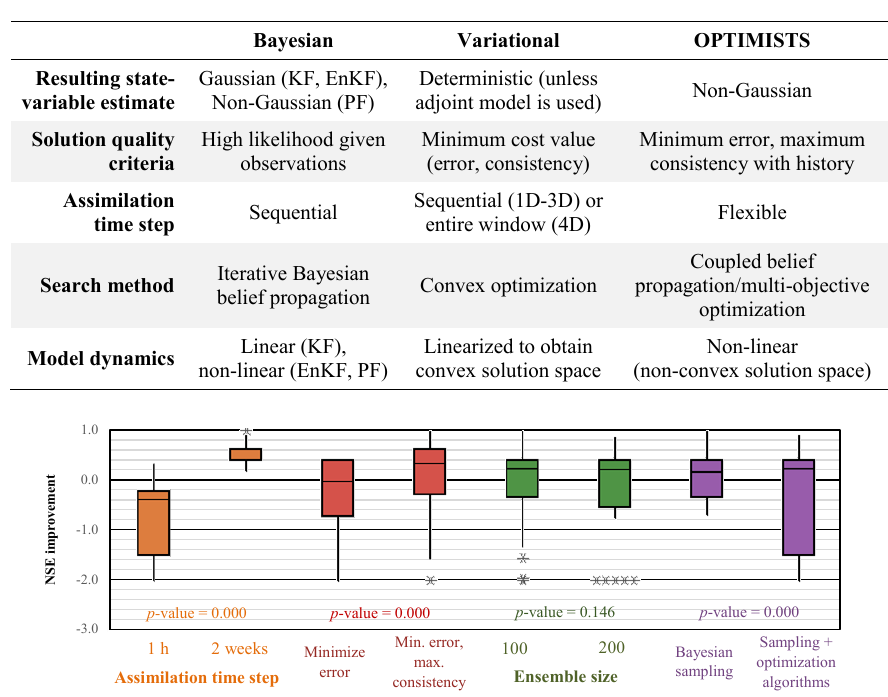
Figure 12. The success of hydrological prediction depends largely on the accuracy of the initialization of the forecast model. Advanced mathematical tools (i.e., data assimilation algorithms) are now available to transform a given set of observations into the best forecast initialization possible. The table above outlines the features of three data assimilation approaches: standard Bayesian data assimilation algorithms (KF stands for Kalman filter, EnKF stands for ensemble Kalman filter, and PF stands for particle filter), variational methods, and a new technique – Optimized PareTo Inverse Modeling through Integrated Stochastic Search (OPTIMISTS) – that combines the advantageous characteristics of the first two. Some of the features selected for OPTIMISTS, such as non-Gaussian probabilistic estimation and support for non-linear model dynamics, are considered advantageous in the literature (van Leeuwen, 2015); flexible configurations are available for other features (e.g., the choice of optimization objectives or the analysis time step) for which no consensus has formed. In the bottom panel, different configurations of OPTIMISTS (indicated along x axis) are compared in terms of their success in improving streamflow forecasts. The experiments were conducted with the Distributed Hydrology Soil Vegetation model (DHSVM) on a test case with 1472 cells and over 30000 state variables; the ordinate shows the change, relative to a control that uses no data assimilation, in the Nash–Sutcliffe efficiency (NSE) coefficient (positive values indicating forecast skill improvement). Asterisks on the box plots indicate outliers. Three configurations of OPTIMISTS provide statistically significant advantages (demonstrated by the indicated p values from the analysis of variance – ANOVA): (i) setting the analysis time step equal to the entire 2-week assimilation period; (ii) maximizing the consistency of the states with the background (and not only minimizing the error); and (iii) using only Bayesian sampling to generate new members/particles. Studies like this are critical for maximizing the effectiveness of the techniques used to initialize forecast models; this particular study positions OPTIMISTS as a capable and flexible framework. (Contact: Xu